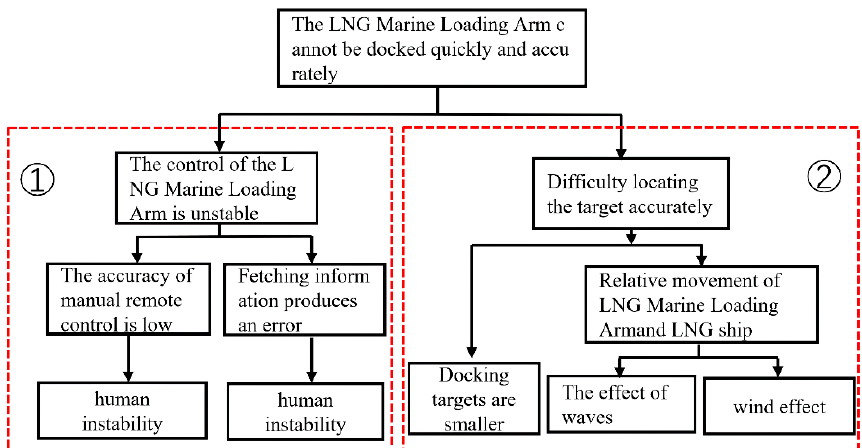
Figure 4. Causal chain analysis of problems.